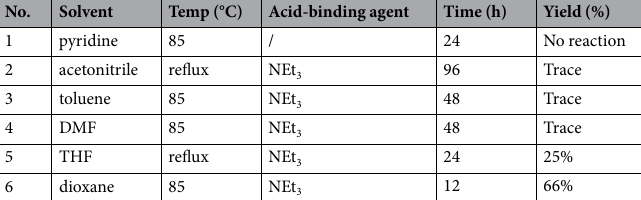
Compd. R 1 Pupation Rate (%) Compd.